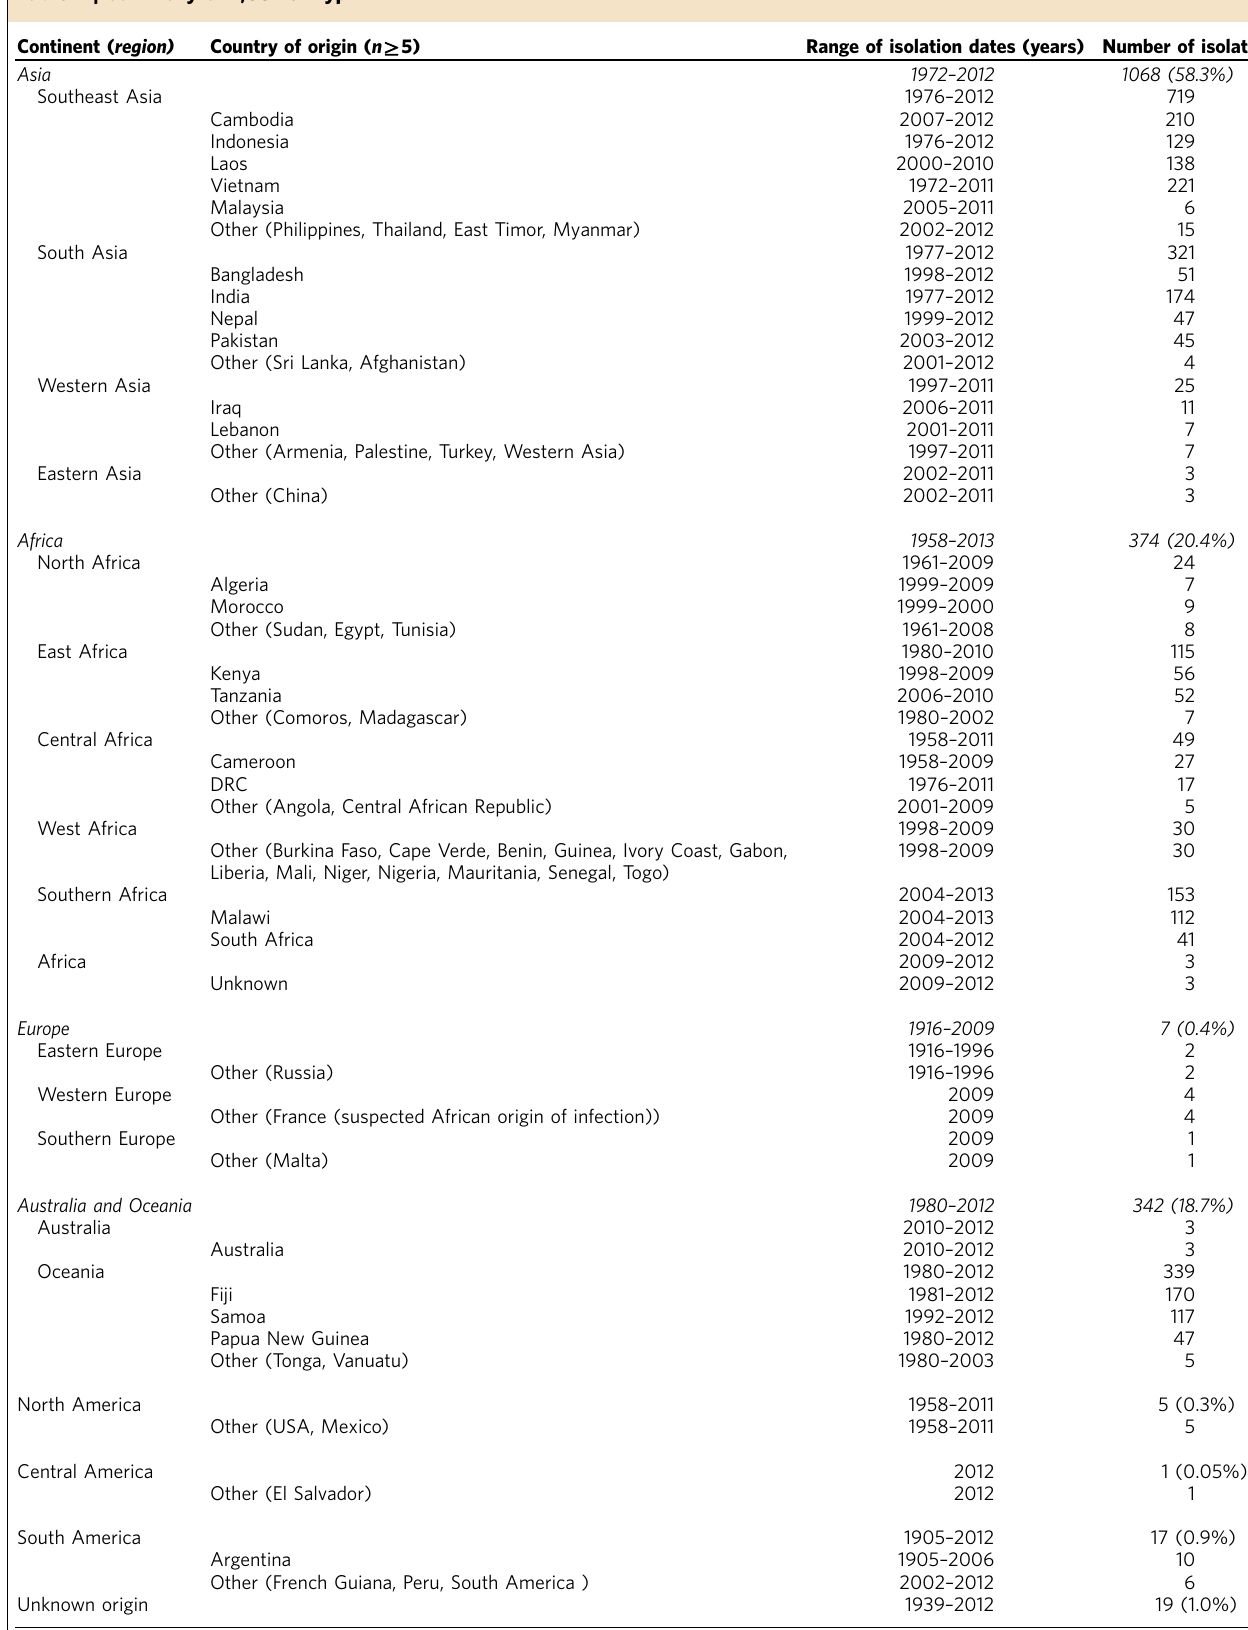
Table 1 | Summary of 1,831 S .